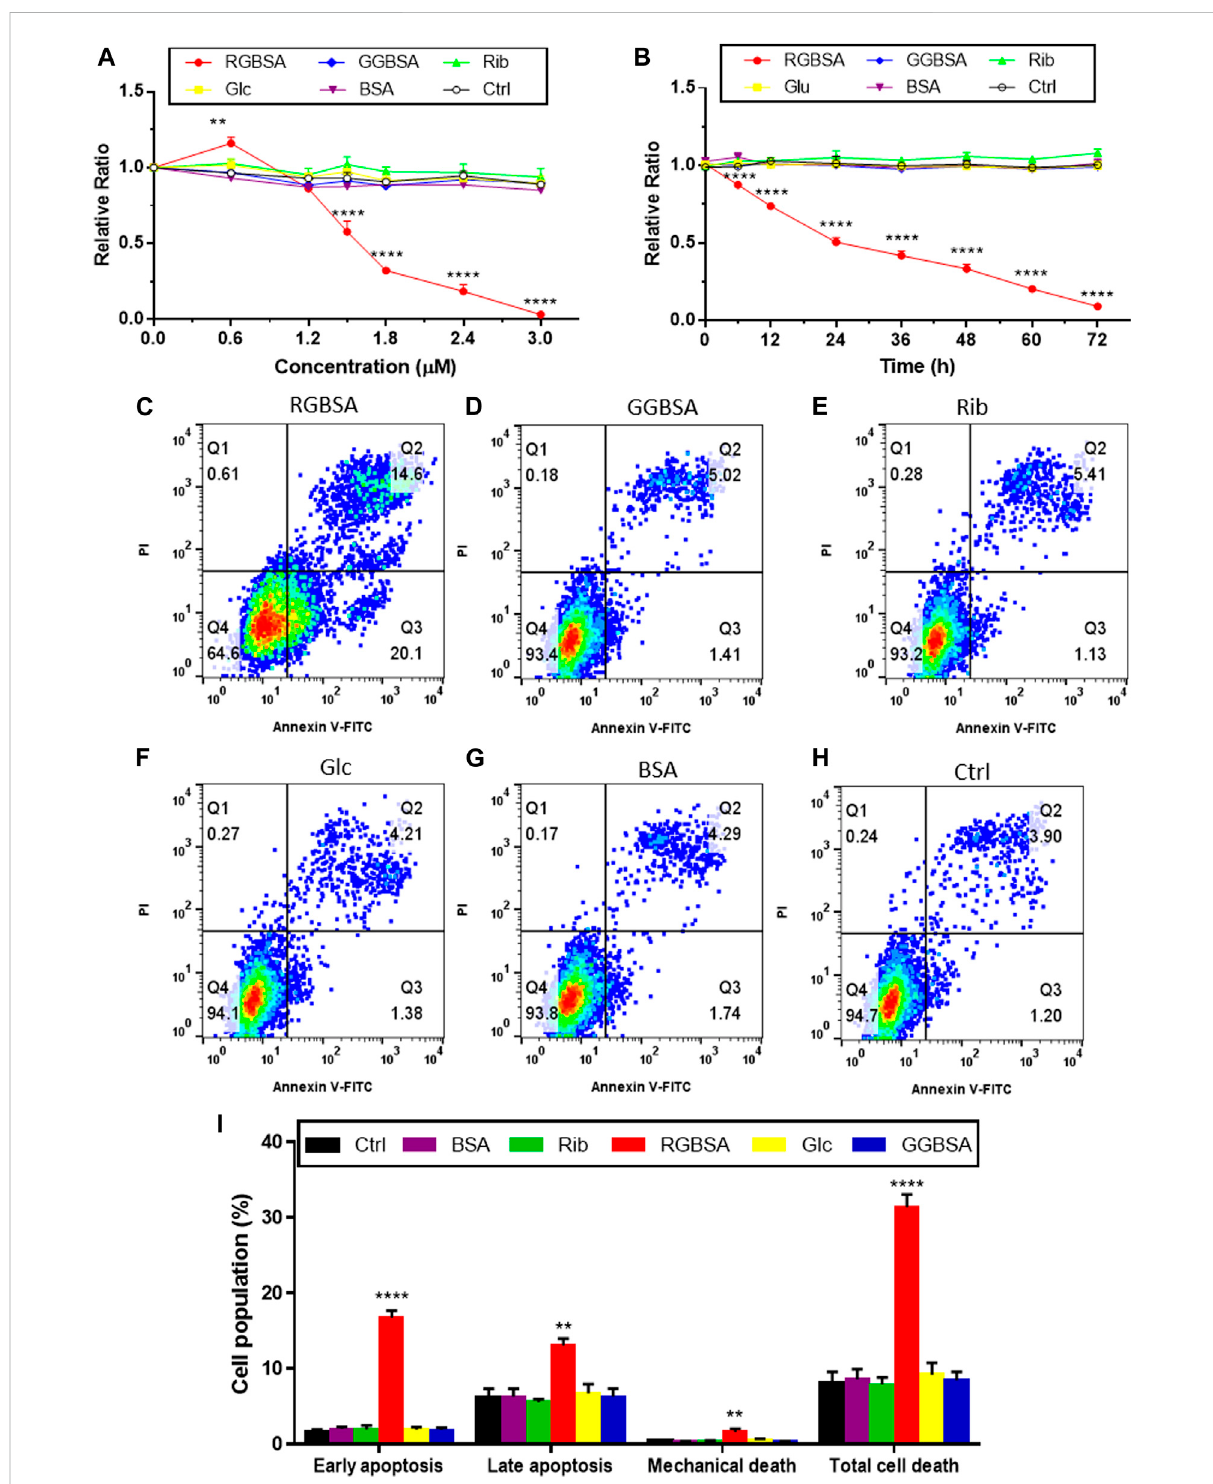
FIGURE 3 Riboglycated BSA induces SH-SY5Y cell apoptosis. Experimental conditions were the same as in Figure 1, except for SH-SY5Y cells that were incubatedwithdifferentconcentrationsofriboglycatedBSA(0,0.6,1.2,1.5,1.8,2.4,and3 μ M)followedbythemeasurementofcellviabilityafter24 h (A) or SH-SY5Y cells that were incubated with 1.5 μ M riboglycated BSA for different time periods (0, 6, 12, 24, 36, 48, 60, and 72 h) followed by the measurement of cell viability (B) . Data were analyzed by two-way ANOVA and are presented as the mean ± SEM ( n = 3). ** p < 0.01 and **** p < 0.0001 compared to the control group. Flow cytometry was used to assess apoptosis of SH-SY5Y cells cultured for 24 h in the presence of 1.5 μ M RGBSA (C) , GGBSA (D) , ribose (E) , glucose (F) , BSA (G), and Tris – HCl buffer (H) . Percentages of apoptosis were determined by Annexin V/FITC-PI staining (I) . Data were analyzed by one-way ANOVA and are presented as the mean ± SEM ( n = 3). ** p < 0.01 and **** p < 0.0001 compared to the control group. Abbreviations: RGBSA, riboglycated BSA; GGBSA, glucoglycated